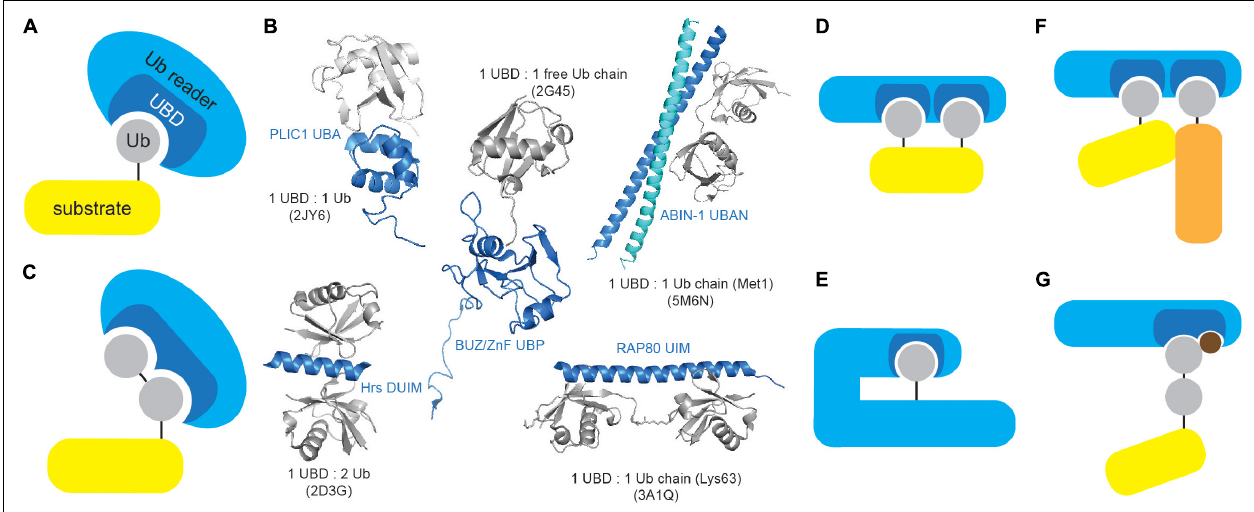
FIGURE 3 | Ubiquitin-binding domains come in different shapes and forms. (A) Ub receptors contain single or multiple (identical or different) motifs or domains that non-covalently bind Ub or Ub chains. (B) UBDs differ in shape and Ub/Ub chain specificity. Several UBDs in complex with Ub or Ub chains are depicted: PLIC1 UBA (Ub-associated, PDB code: 2JY6), Hrs DUIM (double-sided Ub-interacting motif, PDB code: 2D3G), ZnF UBP/BUZ (zinc-finger Ub-binding, PDB code: 2G45), ABIN-1 UBAN (Ub-binding domain in ABINs and NEMO, PDB code: 5M6N) and RAP80 tandem UIMs (Ub-interacting motif, PDB code: 3A1Q). Ub and UBD structures are depicted in gray and blue, respectively. The figure was generated from PDB entries by PyMOL v1.7.6.0 software. (C) A subset of UBDs recognizes specific types of Ub modifications, such as specific Ub linkages. (D) Cooperative recognition of Ub modifications by two or more UBDs is one of many approaches to increase avidity of Ub:UBD interaction. (E) Monoubiquitinated proteins can bind their intrinsic UBDs to regulate their function. The interaction between Ub modification and UBD (on the same protein) provides an efficient switch between active and inactive Ub receptor conformation. (F) Ub:UBD interactions often lead to formation of large protein complexes. Most of the Ub:UBD interactions are relatively weak. Multiple UBDs, due to avidity, contribute to the strengthened interaction between Ub and UBDs. Such multiple UBDs and Ub modifications enable formation of highly dynamic protein complexes. (G) A subset of UBDs could potentially recognize specific PTM-modified Ub